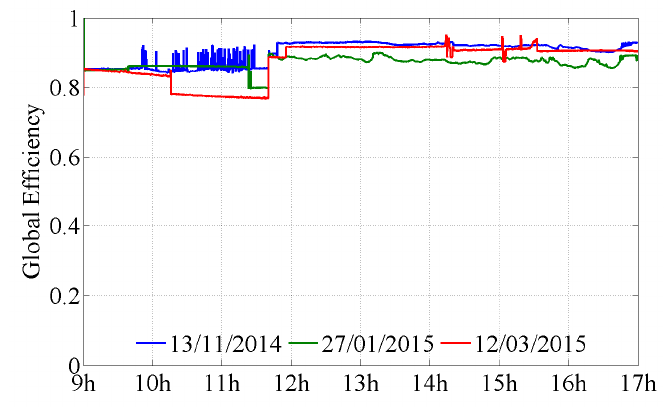
Figure 11. Comparison of the DC microgrid global efficiencies of the three days for DCE method.